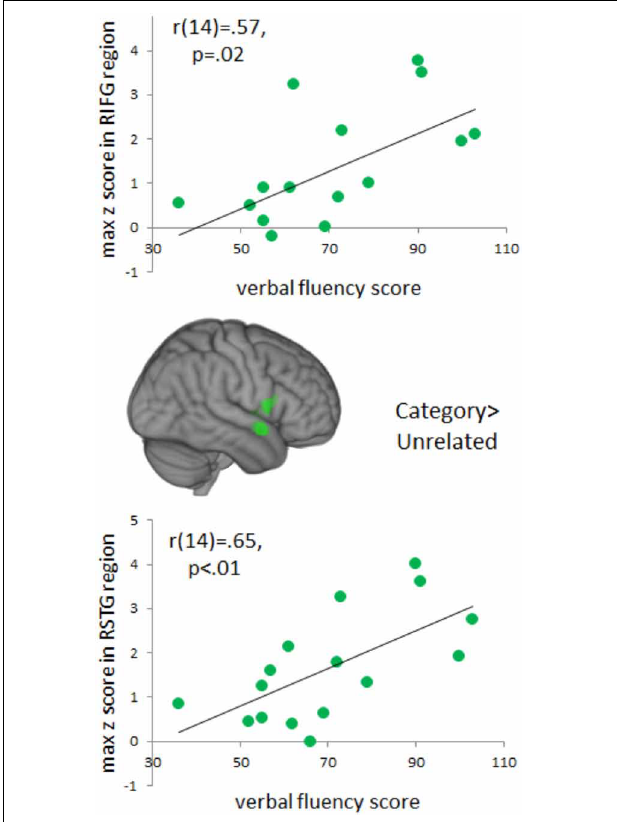
FIGURE 6 | Brain Activations to Verbal Fluency. Areas in green indicate voxels where total verbal fluency (F, A, S, and animals) correlated positively with activation to the categorically-related condition. A cluster of significant correlations was found in right anterior, superior temporal gyrus and this cluster extended into right inferior frontal gyrus. Positive correlations represent areas that increased in activation as a function of an individual’s total verbal fluency score. Activations are scaled in terms of significant Z -values, and all comparisons are presented at a cluster-corrected threshold of p < 0 .